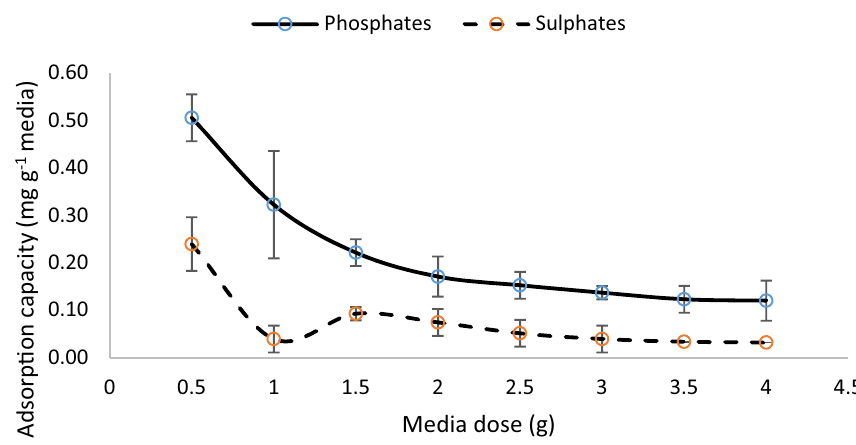
Fig. 7 Effect of media dosage on the adsorption of phospho- rus and sulphates onto treated copper smelter slag